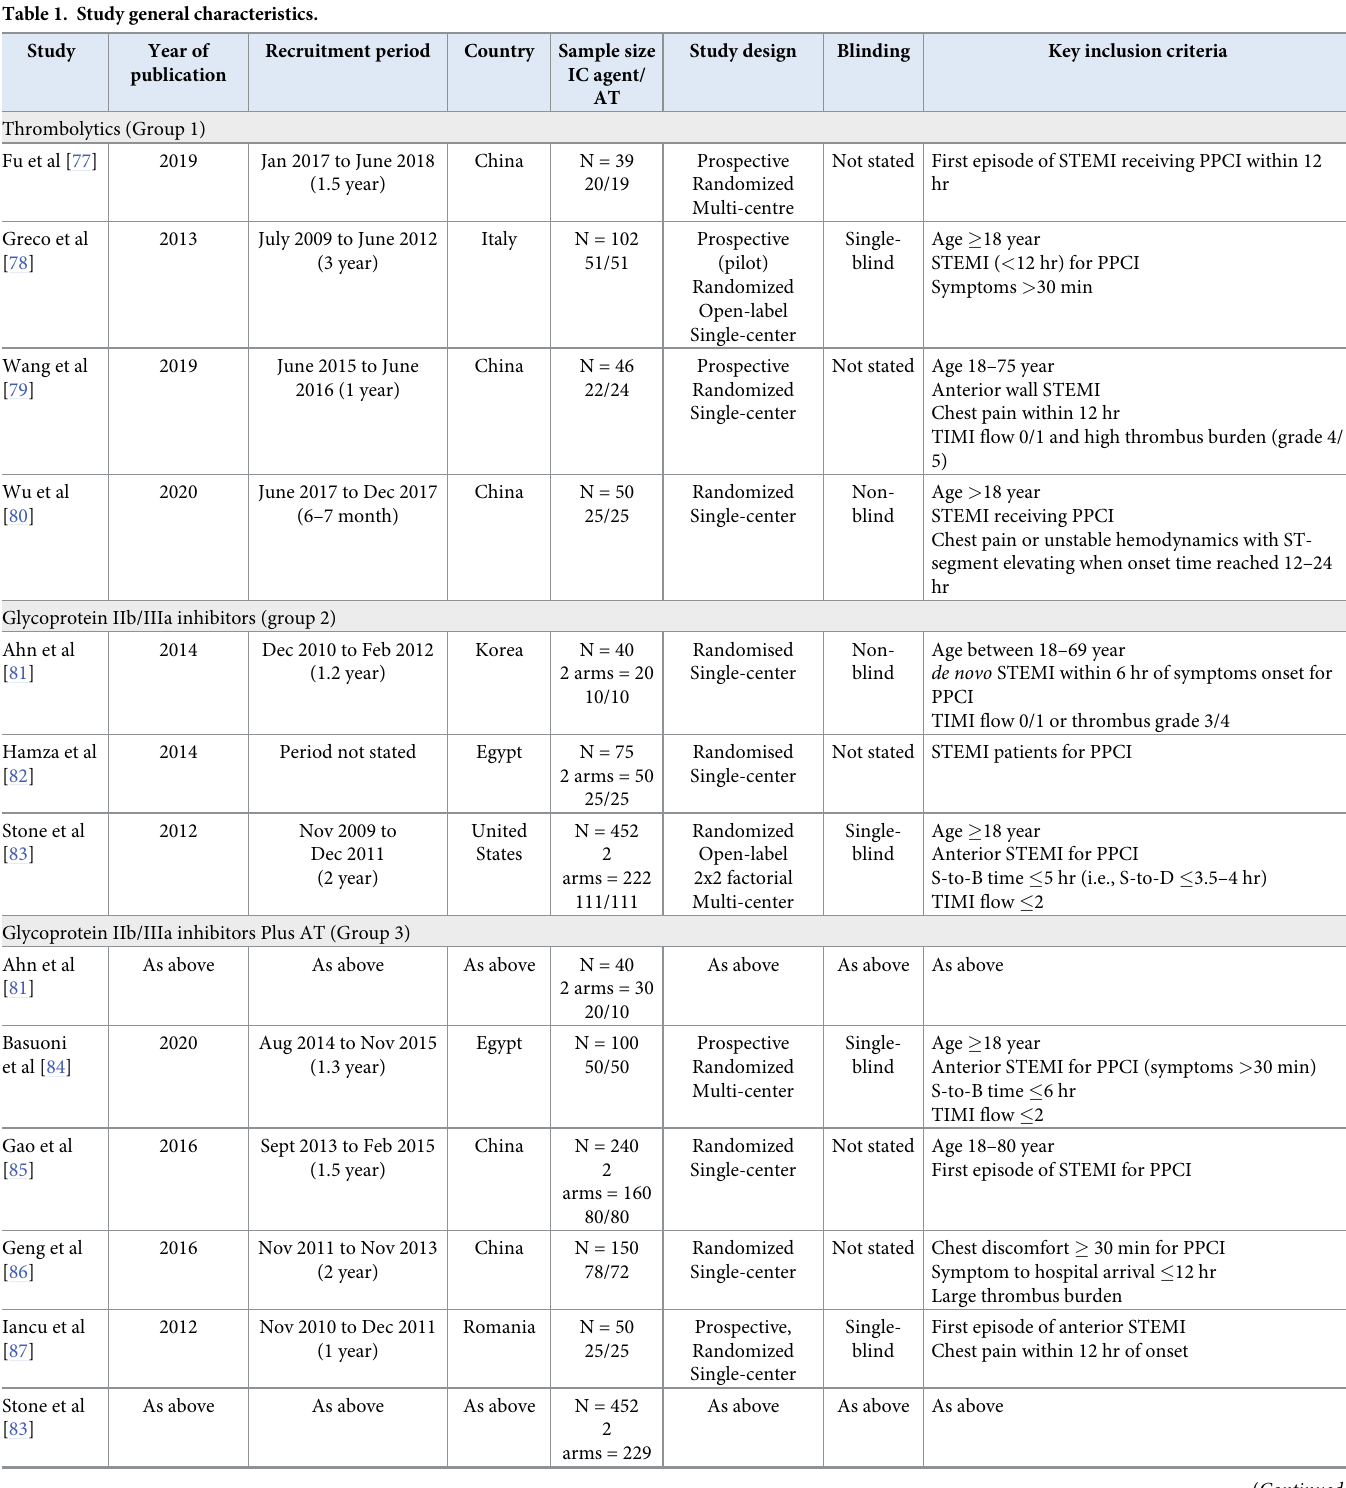
Table 1. Study general